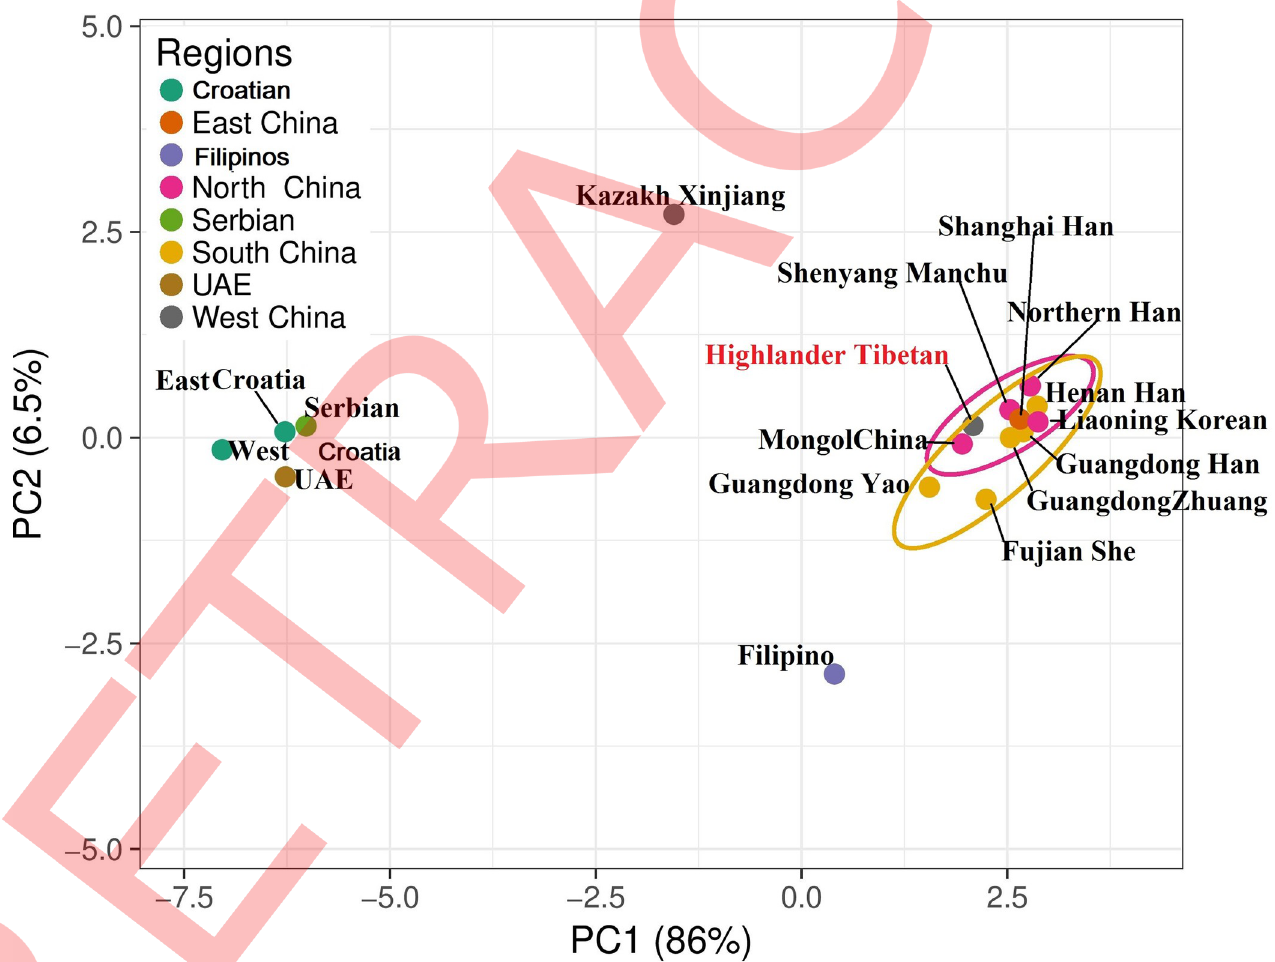
Fig 3. Principal component analysis (PCA) based on Nei’s genetic distance revealed by the first two components between Highlander Tibetans and 16 other populations.